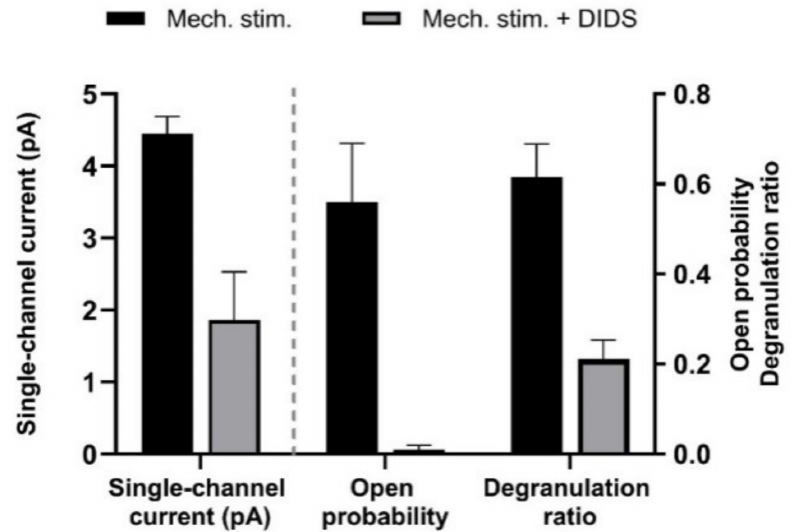
Figure 11. Effect of mechanical stress on single-channel activity and degranulation ratio of human MCs (HMC-1 cell line). Channel activity was induced in outside-out membrane patches by applying negative pressure to the pipette ( − 40 cm H 2 O); the test potential was + 80 mV. 200 µ M DIDS reduced single-channel-current amplitude as well as open-state probability. Degranulation was observed under inverted light microscope. Data represent means + SEM ( n = 3–4), and are based on Wang et al. (2010)